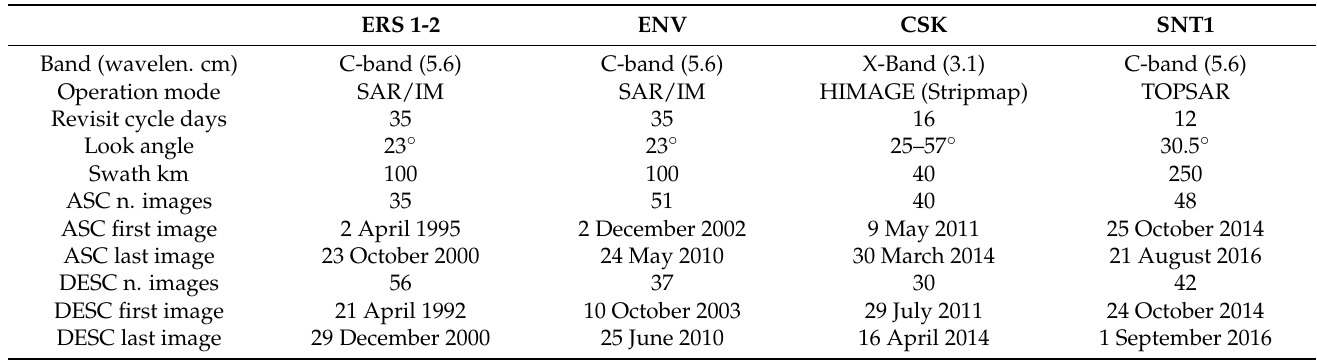
Table 2. The 1993–2016 PS dataset covering the study area derives from SAR data acquired by four satellites carrying sensors operating in the C (ERS, ENV and SNT) and X bands (CSK). The dates are expressed in the dd/mm/yyyy format.